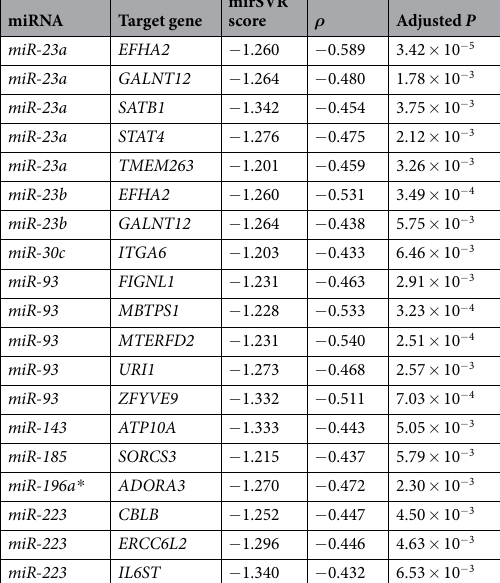
Table 1. Sarcoidosis-related miRNA and target gene pairs. Note – ρ is the Spearman’s rank correlation coefficient. P -values were calculated by Spearman’s rank correlation test between miRNA and target gene expression levels and adjusted by Benjamini & Hochberg procedure.